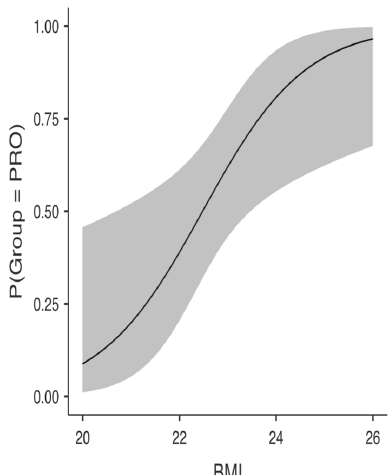
Figure 1. U19 body height probability to become professionals (PRO).